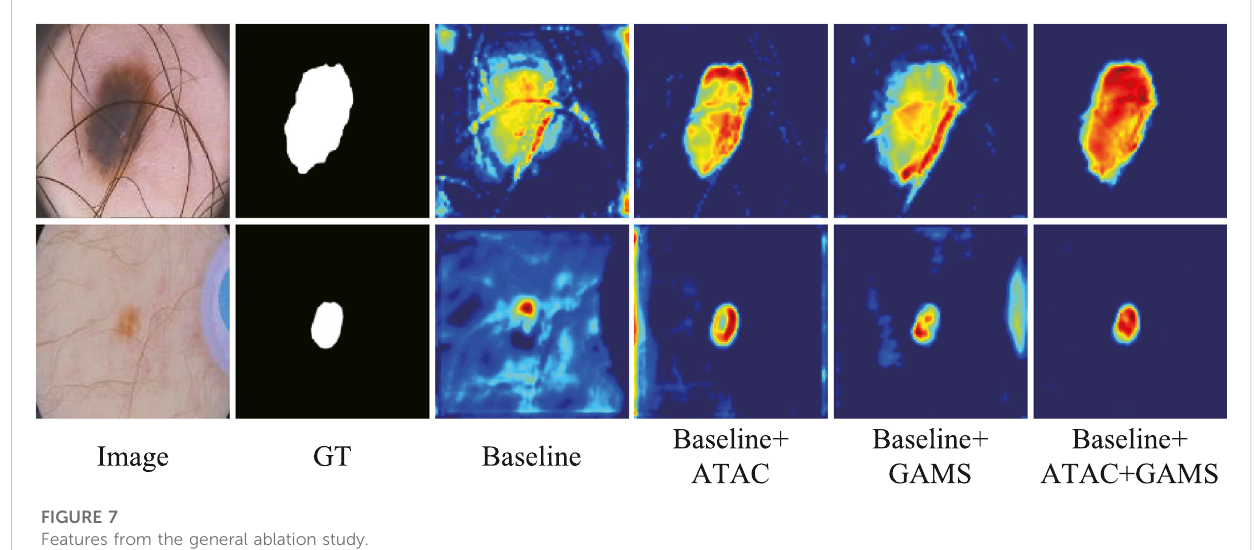
FIGURE 7 Features from the general ablation study.